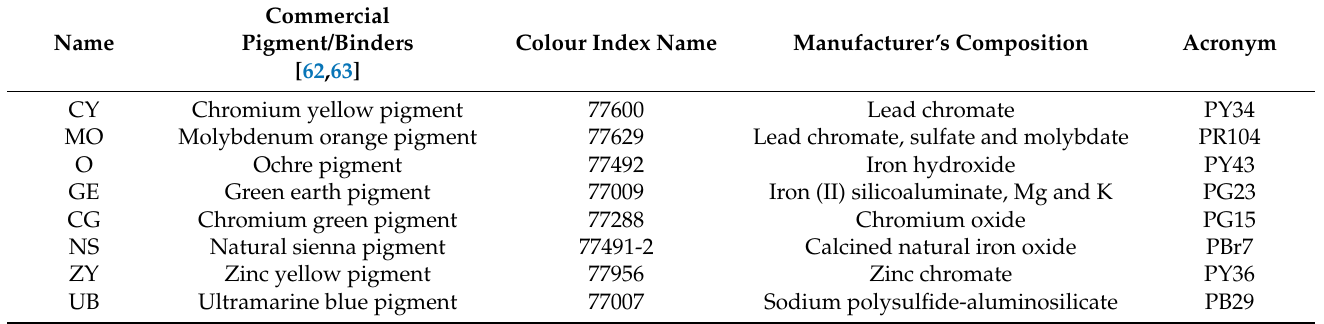
Table 1. List of pigments along with an indication of the identification used in the study carried out, trade name, color index, composition and acronym.